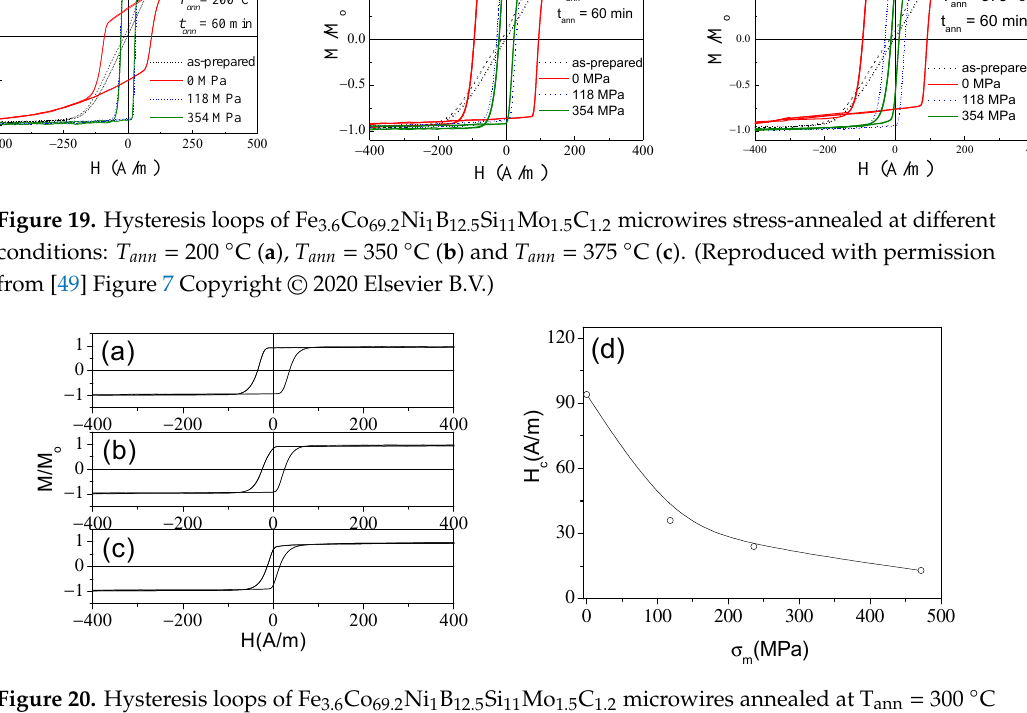
Figure 20. Hysteresis loops of Fe 3.6 Co 69.2 Ni 1 B 12.5 Si 11 Mo 1.5 C 1.2 microwires annealed at T ann = 300 °C for t ann = 1 h under σ m = 118 ( a ), σ m = 236 ( b ) and σ m = 472 MPa ( c ) and H c ( σ m ) dependence at T ann = 300 °C for t ann = 1 h ( d ).